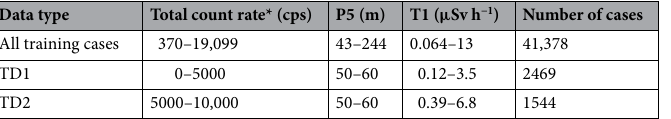
Table 2. Limited training set for evaluating the neural network condition. *Sum of P1, P2, P3, and P4.